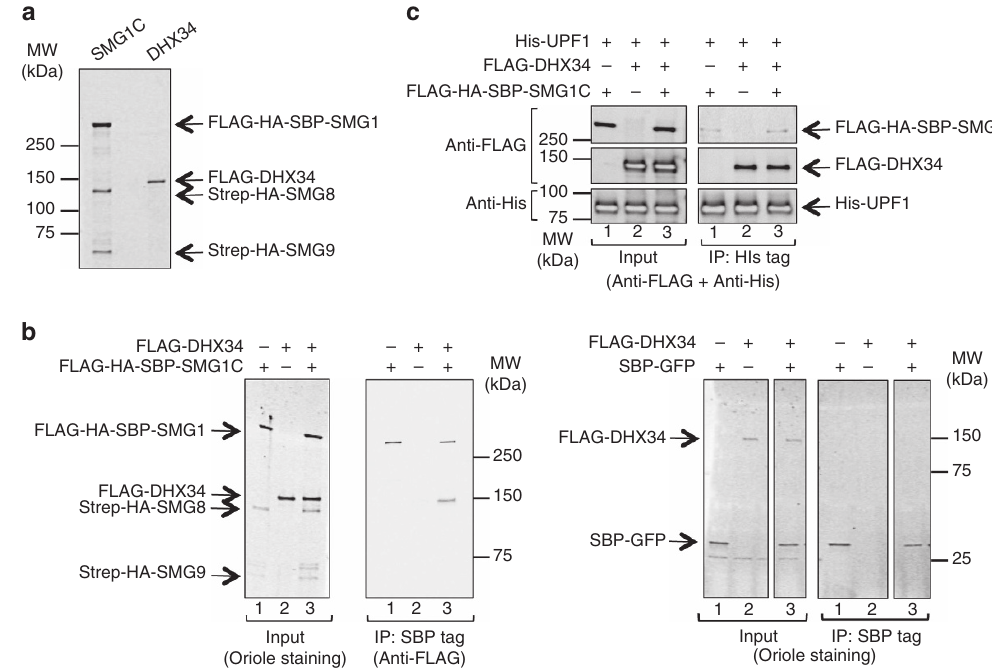
Figure 2 | Interactions between SMG1C and DHX34. ( a ) SDS–PAGE of purified FLAG-DHX34 and FLAG-SBP-HA-SMG1C used for structural studies. Purified proteins were resolved in a 4–15% SDS–PAGE and stained using Oriole Fluorescent Gel Stain. ( b ) Pull-down experiment testing the interaction of purified FLAG-DHX34 and FLAG-SBP-HA-SMG1C. Proteins bound to Streptavidin Sepharose beads were eluted using biotin and analysed by SDS–PAGE and western blotting against the FLAG-tag in SMG1 and DHX34. Right panel shows a control experiment demonstrating that DHX34 is not eluted when SBP-GFP is used as bait instead of FLAG-SBP-HA-SMG1C. ( c ) Pull-down experiment testing the interaction of His-UPF1 with FLAG-SBP-HA-SMG1C and FLAG-DHX34. Proteins were mixed and His-UPF1 bound to and eluted from the beads. SDS–PAGE (4–15%) where proteins were identified by western blotting using antibodies against the FLAG and His